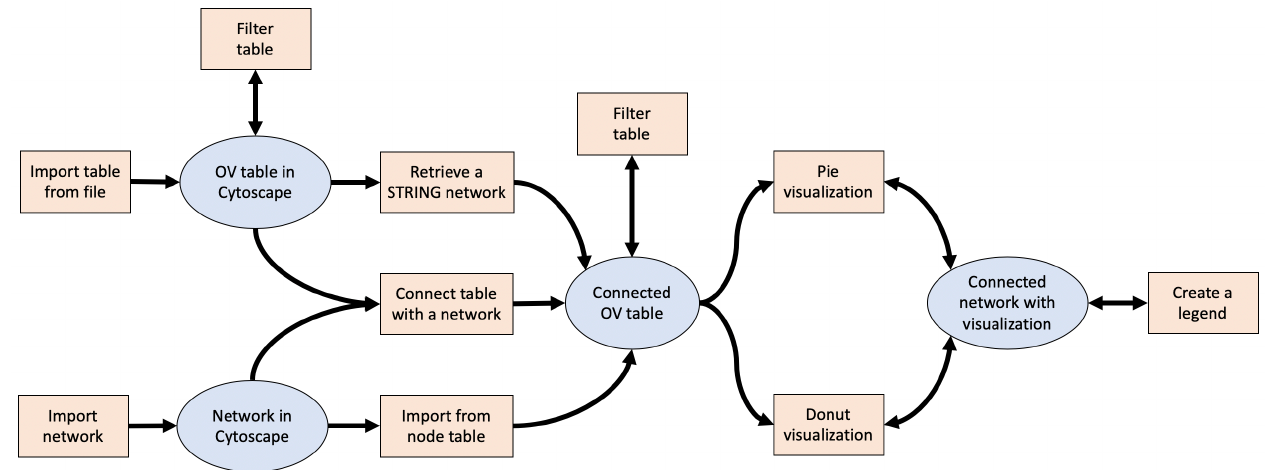
Figure 1. Workflow for visualizing data with Omics Visualizer. This workflow shows the three possible ways to obtain an Omics Visualizer table connected with a network, to then visualize the data with pie and/or donut